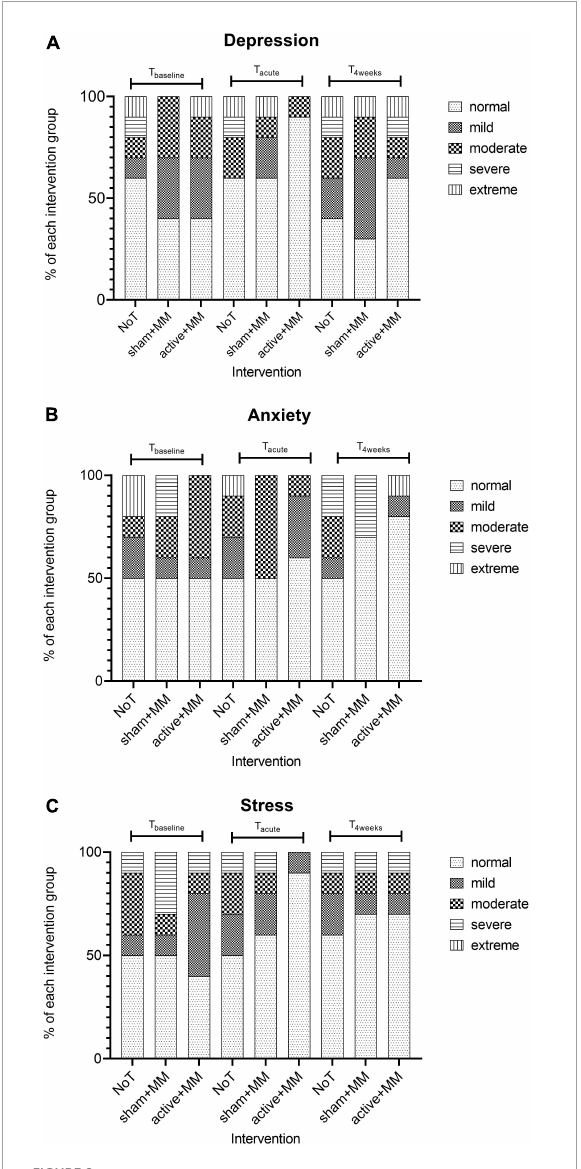
FIGURE8 Effects of the tDCS and MM therapy on psychological wellbeing. Bar charts illustrating the changes in the percentage of participants with different levels of severity of (A) depression (B) anxiety and (C) stress in each intervention group at baseline, up to five days and 4 weeks after last stimulation session.